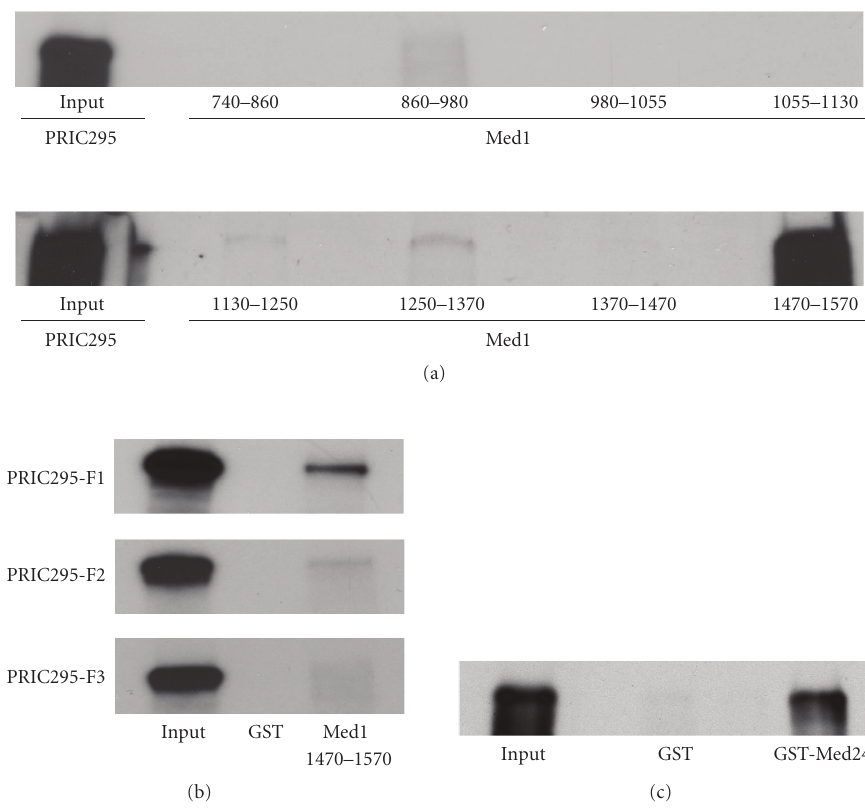
Figure 9: PRIC295 interacts with Med1. (a) In vitro translated and radiolabeled PRIC295 protein interacts with the known PPAR α coactivator, Med1, as assessed by GST-pulldown approach using GST-fusion protein fragments of the PBP protein. Interaction between PRIC295 and GST- Δ PBP6 1470–1570 appears robust. (b) GST-pulldown of radiolabeled Δ PRIC295 1–915 (F1), Δ PRIC295 840–1815 (F2), and Δ PRIC295 1740–2671 (F3), respectively, using GST- Δ PBP 1470–1570 showing a strong binding interaction occurring between Δ PRIC295 1–915 (F1) and GST- Δ PBP 1470–1570